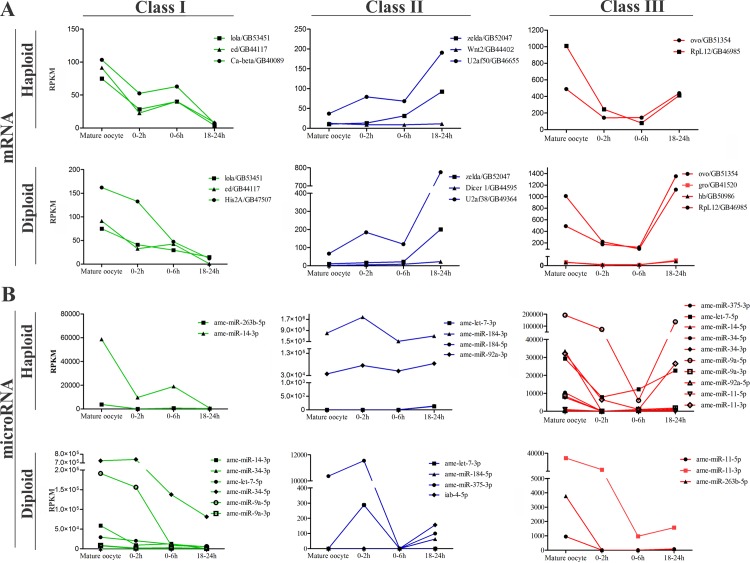
Expression profile of certain mRNAs and miRNA of each class in the early embryogenesis of Apis mellifera.(A) Profile of mRNAs belonging to the three different classes of genes: I, II, and III. Examples of mRNAs from class I, II and III are plotted in a separated graphic for the haploid and diploid embryos. (B) Profile of miRNAs belonging to class I, II, and III. Note the differential expression and arm use among the embryo types (such as ame-miR-184-3p and 5p of class II and ame-miR-263-5p of class II in haploids but class III in diploids). The total number of identified mRNAs for each class is as follows: class I, 667 in diploid and 475 in haploid embryos; class II, 2680 in diploid and 475 in haploid embryos; class III, 263 in diploid and 147 in haploid embryos. The total number of miRNAs for each class is as follows: class I, 90 in diploid and 72 in haploid embryos; class II, 23 in diploid and 24 in haploid embryos; class III, 37 in diploid and 67 in haploid embryos. Overall, the distribution demonstrates specific gene expression dynamics for mRNAs and miRNA in both types of embryos. The Expression and DEGseq output of the mRNAs and miRNAs plotted here are listed in S5 Table.